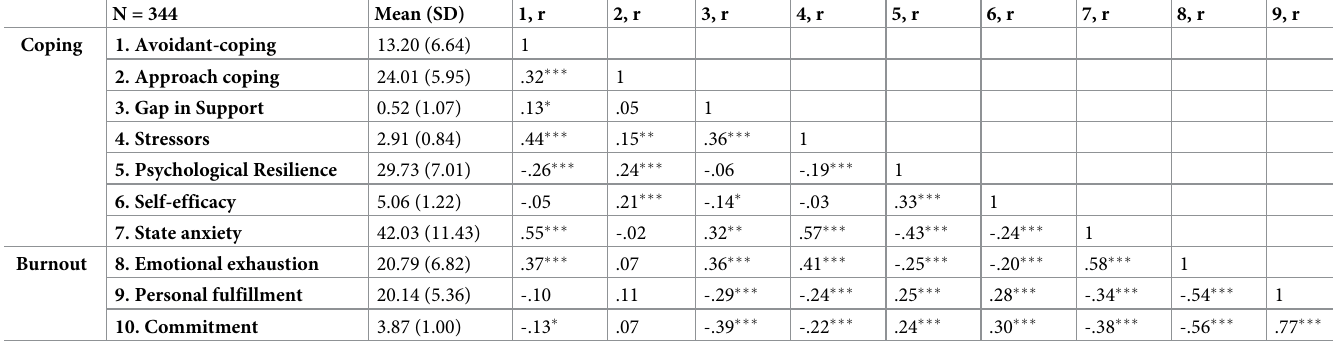
Table 2. Descriptive statistics and Pearson correlational analyses a of the relationship between study variables. N =